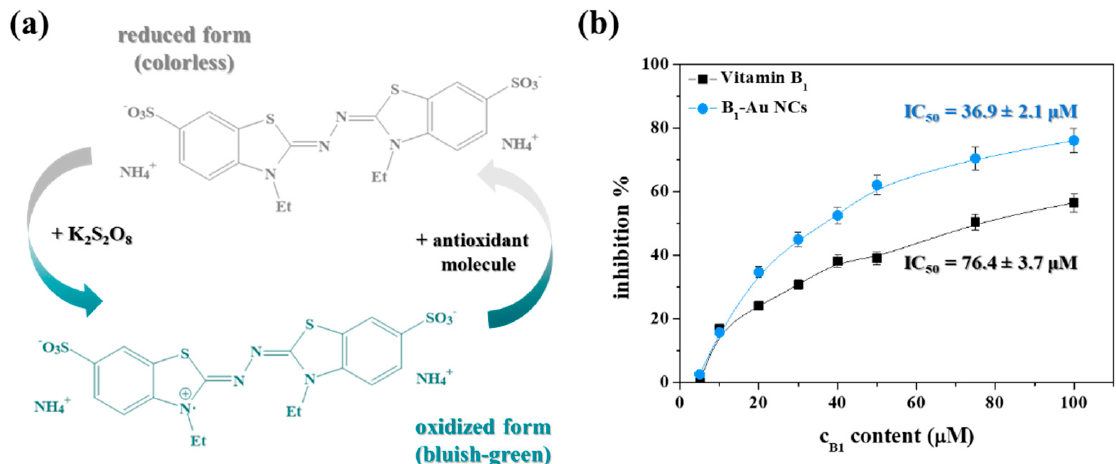
Figure 2. ( a ) The transformation of the ABTS molecule during the antioxidant measurement protocol from the reduced form to the oxidized form. ( b ) The radical scavenging activity curve ( λ abs = 734 nm, T = 25 °C) of the pure Vitamin B 1 ( ■ ) and the B 1 -Au NCs ( ● ) applying 5–100 µM B 1 content.